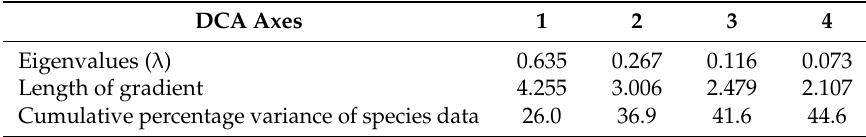
Table 3. Summary of a Detrended correspondence cnalysis (DCA) of the 11 species of gastropods in 32 sites.